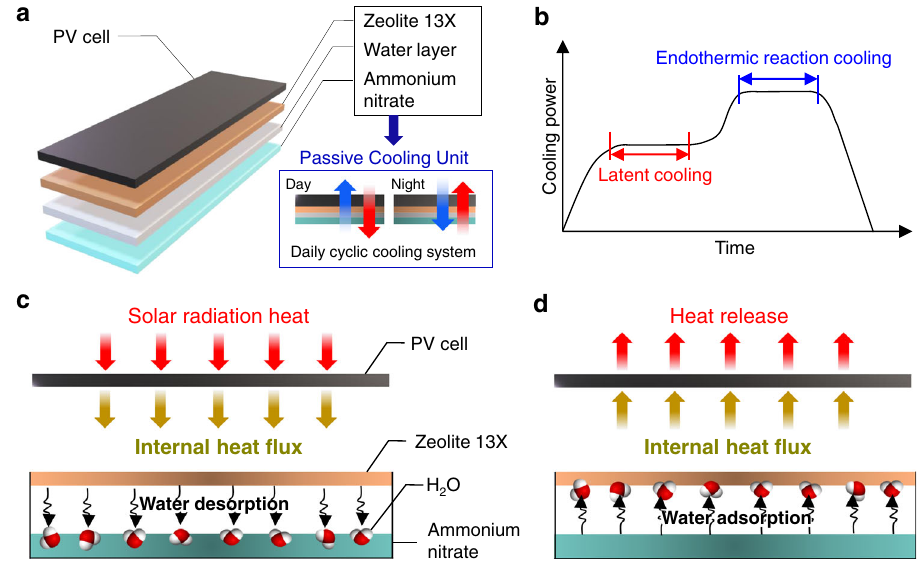
Fig. 1 | Overview of the passive cooling unit. a Schematic representation of self- recovering passive cooling unit utilizing the chain reaction of water desorption (primary latent cooling) and dissolution of ammonium nitrate in water (secondary endothermic reaction cooling) integrated with photovoltaic (PV) cell. b Cooling